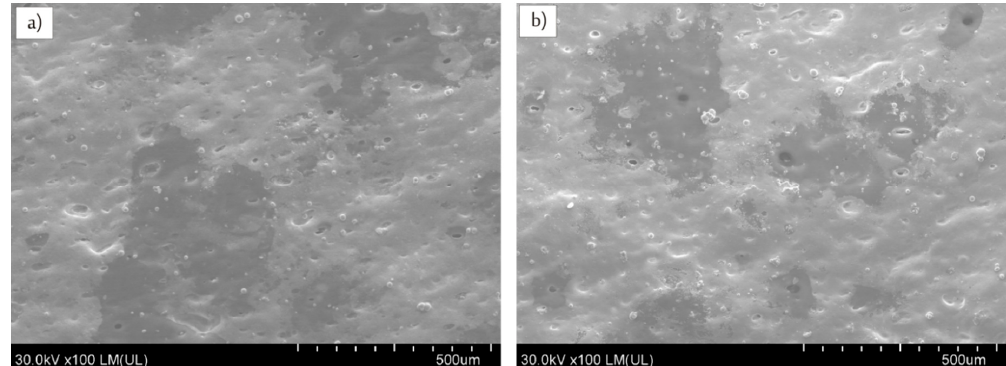
Figure 10. SEM images of composites: a ) D and b ) E, both irradiated and electroless